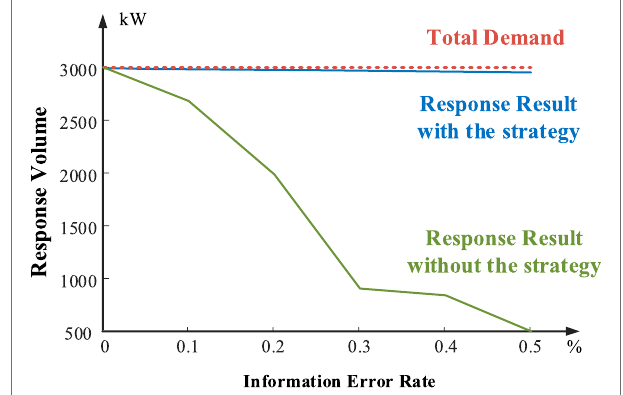
FIGURE 12 | Comparison between adopting the strategy or not in Case 1.